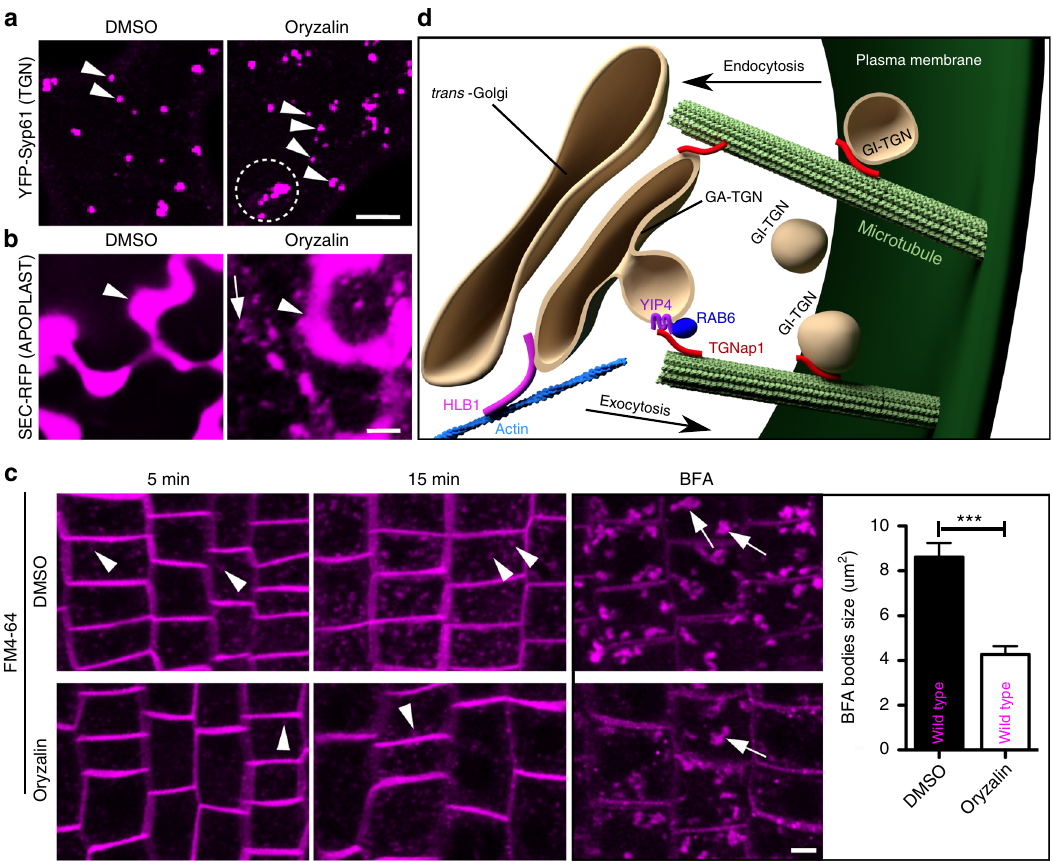
Fig. 8 The loss of MT phenocopies the tgnap1 subcellular phenotypes. a Confocal images of TGNs labeled by YFP-Syp61 in WT cotyledon epidermal cells untreated (DMSO) or treated with oryzalin 10 µ m for 7 h showing appearance of small TGNs (arrowheads) and clustered TGNs (circled with dotted line) in the treated sample compared to the untreated one. b Effect of oryzalin treatment on cotyledon epidermal cells expressing SEC-RFP. The marker is in the apoplast (arrowheads) in untreated and treated cells, but also accumulates in intracellular structures (arrow) in treated cells. c Internalization of FM4 – 64 in WT root cells untreated (DMSO) or treated with oryzalin at 5 min and 15 min. Arrowheads indicate endosomes. Arrows in confocal images indicate BFA bodies, graph indicates BFA bodies size in oryzalin untreated and treated WT plants. WT untreated (DMSO) BFA bodies ( n = 100), WT treated (oryzalin) BFA bodies ( n = 80). Scale bars = 5 µ m. Error bars indicate S.E.M. Student t -test was applied, p -values are represented by asterisks when signi fi cantly different from the corresponding control *** = p < 0.001. d Model for a role of TGNap1 at the TGN. TGNap1 associates to subdomains of a subpopulation of TGNs in plant cells, where it in fl uences biogenesis and function of the TGN as well as the movement of GI-TGN/secretory vesicles through MT. The role of TGNap1 in exocytosis involves Rab6 and YIP4, either as a ternary complex or through sequential protein – protein interactions, but its role in endocytosis is likely independent from YIP4, given the lack of a requirement of YIP4 in endocytosis 41 . Schematic models were made and rendered in the 3D rendering application, Blender (www.blender.org), and further modi fi ed (addition of text and formatted for publication) using the vector-graphics editor Inkscape